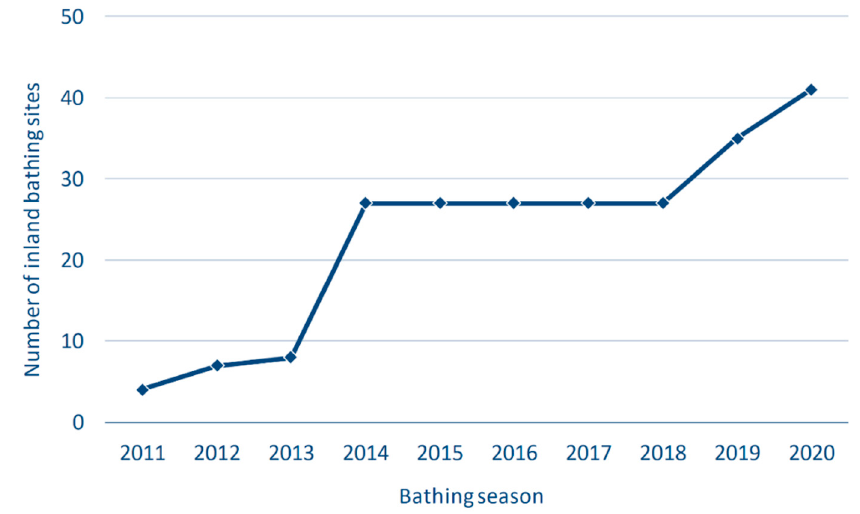
Figure 1. The number of inland bathing sites in Croatia in the period 2011–2020. During the observed period (2011–2020), the number of inland bathing sites (N) in the EU was highest in Germany (N 2011 = 1938; N 2020 = 1941), followed by France (N 2011 = 1304; N 2020 = 1941), Italy (N 2011 = 647; N 2020 = 672) and the Netherlands (N 2011 = 603; N 2020 =